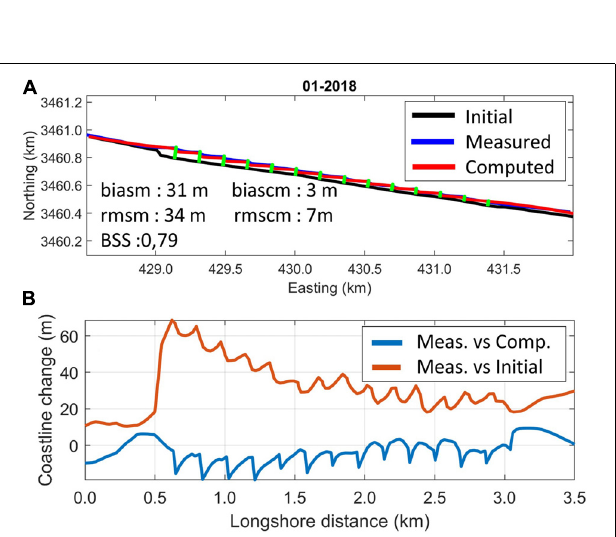
FIGURE 14 | Measured (meas.) and computed (comp.) coastline evolution 2011-2018, Al-Gamil (A) ; observed change and difference between measurements and model results (B)